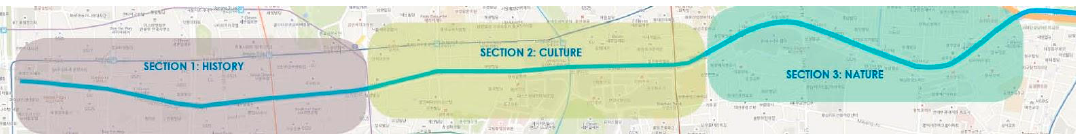
Figure 3. Conceptual divisions of Cheonggyecheon.